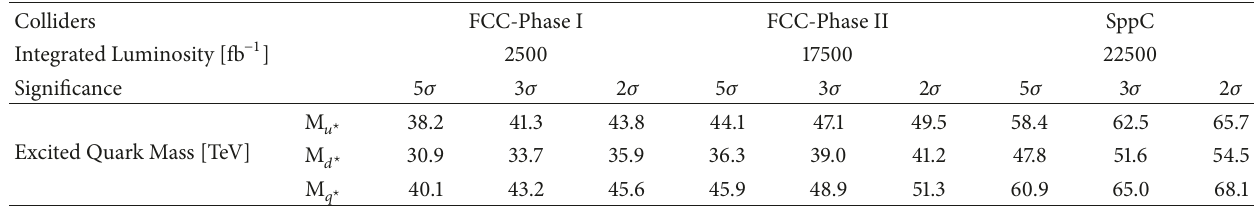
Table 3: Attainable mass limits for all three cases at FCC and SppC with corresponding final integrated luminosity values. Compositeness scale is chosen equal to excited quarks mass values.